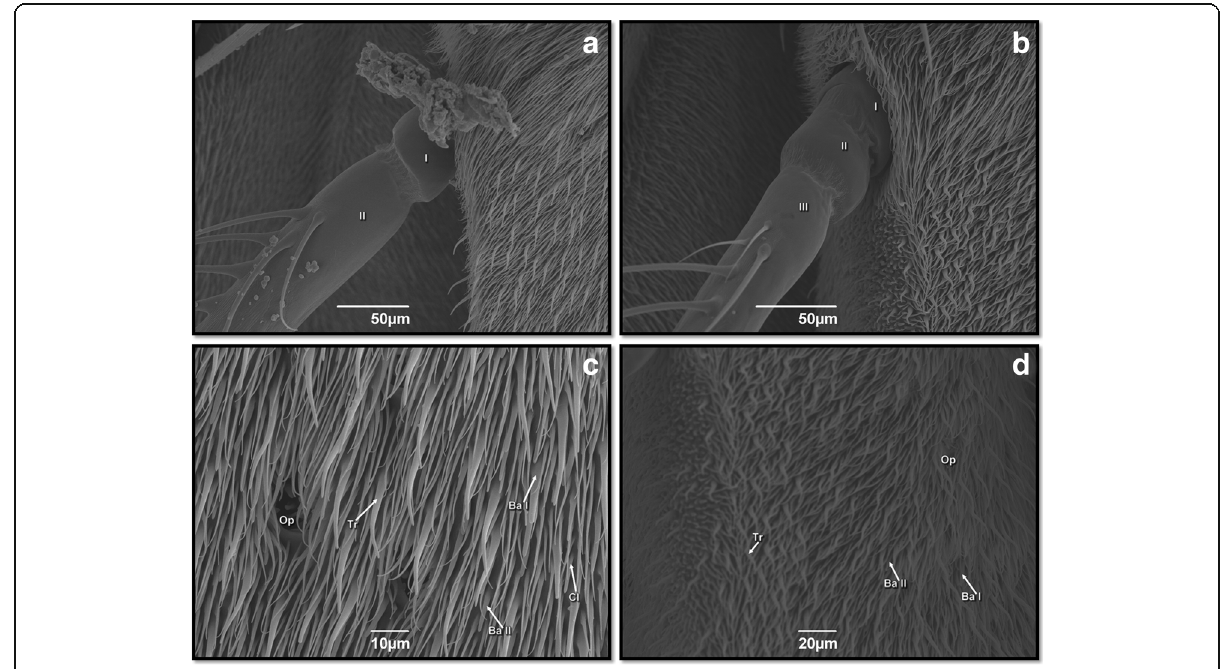
Fig. 4 Scanning electron micrographs showing the cuticular surface of flagellum in both genders of Mesembrinella bellardiana : a arista of female divided in two (I-II) segments (× 450), b arista of male divided in three (I-III) segments (× 500), c first flagellomere of female (× 1200); d first flagellomere of male (× 600). Fn = first flagellomere; Mc = microtrichia; Tr = trichoidea; Ba = basiconic; Cl = clavate; Op = Olfactory